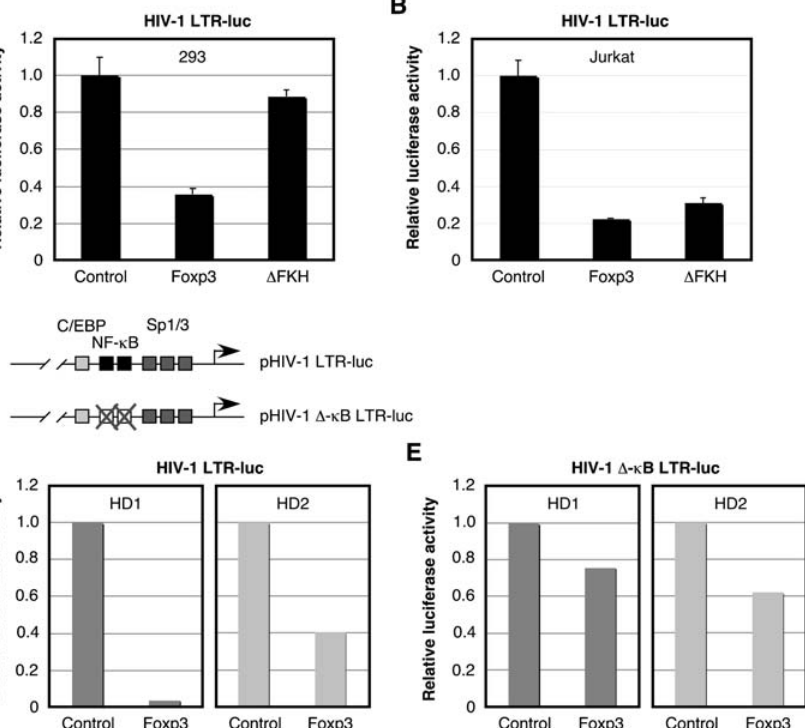
Figure 3. Foxp3 Inhibits Basal Activation of the HIV-1 LTR (A and B) HEK 293T cells (5 3 10 5 ) (A) were seeded into six-well plates 1 d prior to transfection or Jurkat T cells (1 3 10 6 ) (B) were seeded into six-well plates on the day of transfection with an HIV-1 LTR luciferase reporter vector (200 ng) in the presence or absence of a Foxp3, D FKH, or control expression vector (1,000 ng) and internal reference plasmid (pGL4-TKhRluc2; 50 ng). Cells were harvested at 24 h posttransfection and analyzed for luciferase activity. (C) Schematic representation of HIV-1 LTR luciferase reporter constructs pHIV-1 LTR-luc and pHIV-1 D - j B LTR-luc. (D and E) CD4 þ T cells (2 3 10 6 ) from two healthy donors were nucleofected with either parental HIV-1 LTR (D) or HIV-1 LTR lacking NF- j B binding sites (at (cid:1) 102 to (cid:1) 81) (E) (1,000 ng), Foxp3 or control expression vectors (2,000 ng), and an internal reference plasmid (1,000 ng). Cells were harvested 24 h posttransfection and analyzed for luciferase activity. Relative luciferase activity shown in A, B, D, and E was normalized to the internal reference control. DOI: